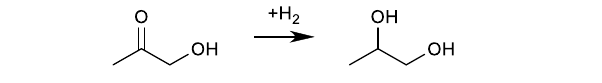
Scheme 1. Reaction pathway of hydroxyacetone during catalytic hydrogenation.